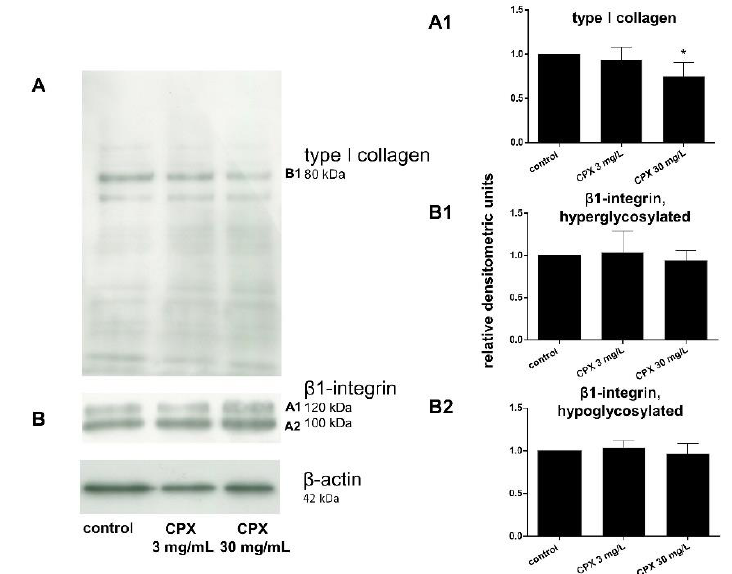
Figure 8. Type I collagen and β1-integrin expression of tenocytes treated with ciprofloxacin as shown by Western blot analysis and densitometric evaluation after 72 h. ( A ) Representative Western blot of type I collagen expression, ( A1 ) densitometric evaluation of the type I collagen Western blots. ( B ) Representative Western blot of β1-integrin expression. The two visible bands (hyperglycosylated and hypoglycosylated forms ( B1 , A2 )) of the β1-integrin were densitometrically evaluated in the Western blots performed for β1-integrin detection. Collagen type I, n = 4: β1-integrin, n = 5: Collagen type I. Independent experiments were performed with cells from di ff erent donors. * p ≤ 0.05 compared to